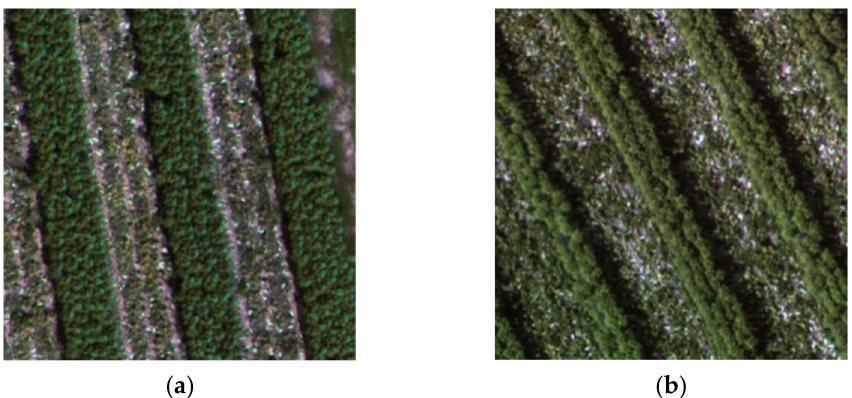
front; ( b ) the angle from the side. ( b ) the angle from the side.